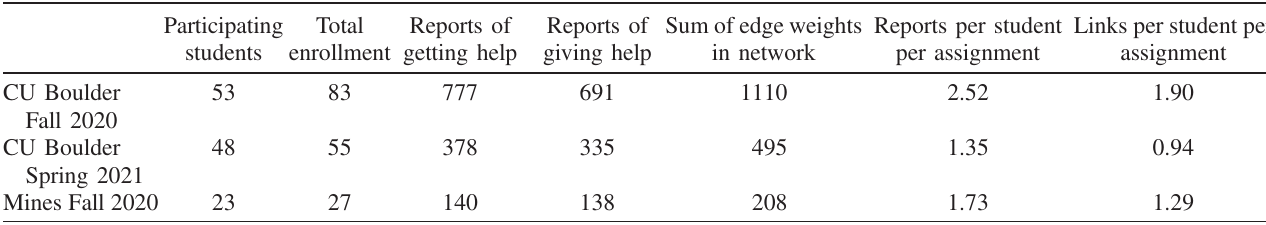
TABLE I. A summary of the results of the data collection on student collaboration. The final two columns directly compare the level of student collaboration since the courses at Mines and CU Boulder had a different number of homework